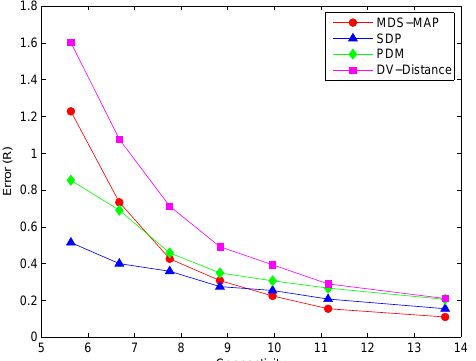
Figure 2 . 50-node networks, 5 anchors, measurement